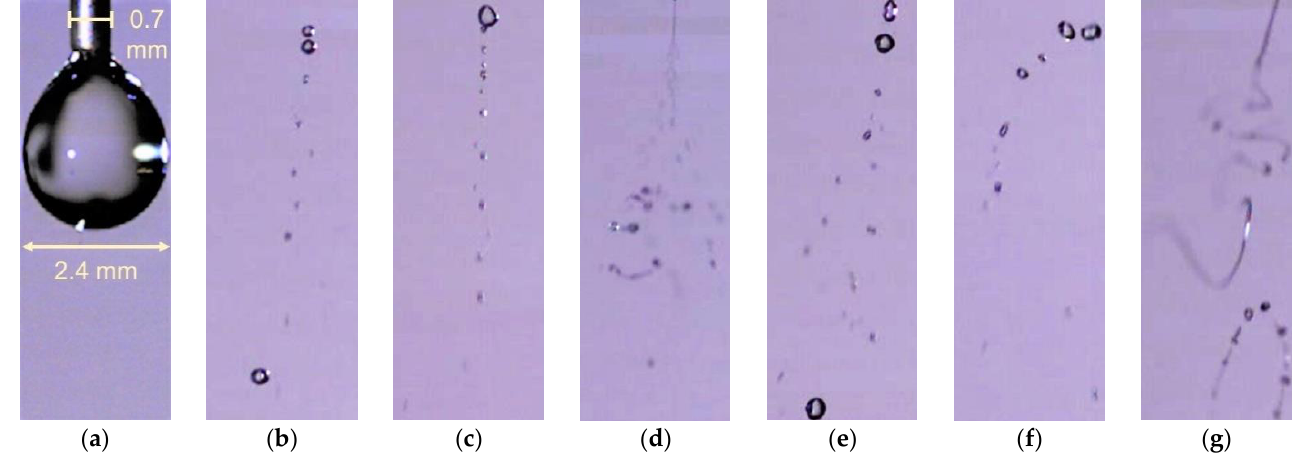
Figure 4. Examples of water droplets photographs by HS camera for different V a (kV) and Q w (µL/min): ( a ) 0 kV; ( b ) 9 kV, 300 µL/min; ( c ) 11 kV, 300 µL/min; ( d ) 13 kV, 300 µL/min; ( e ) 9 kV, 500 µL/min; ( f ) 11 kV, 500 µL/min; ( g ) 13 kV, 500 µL/min.